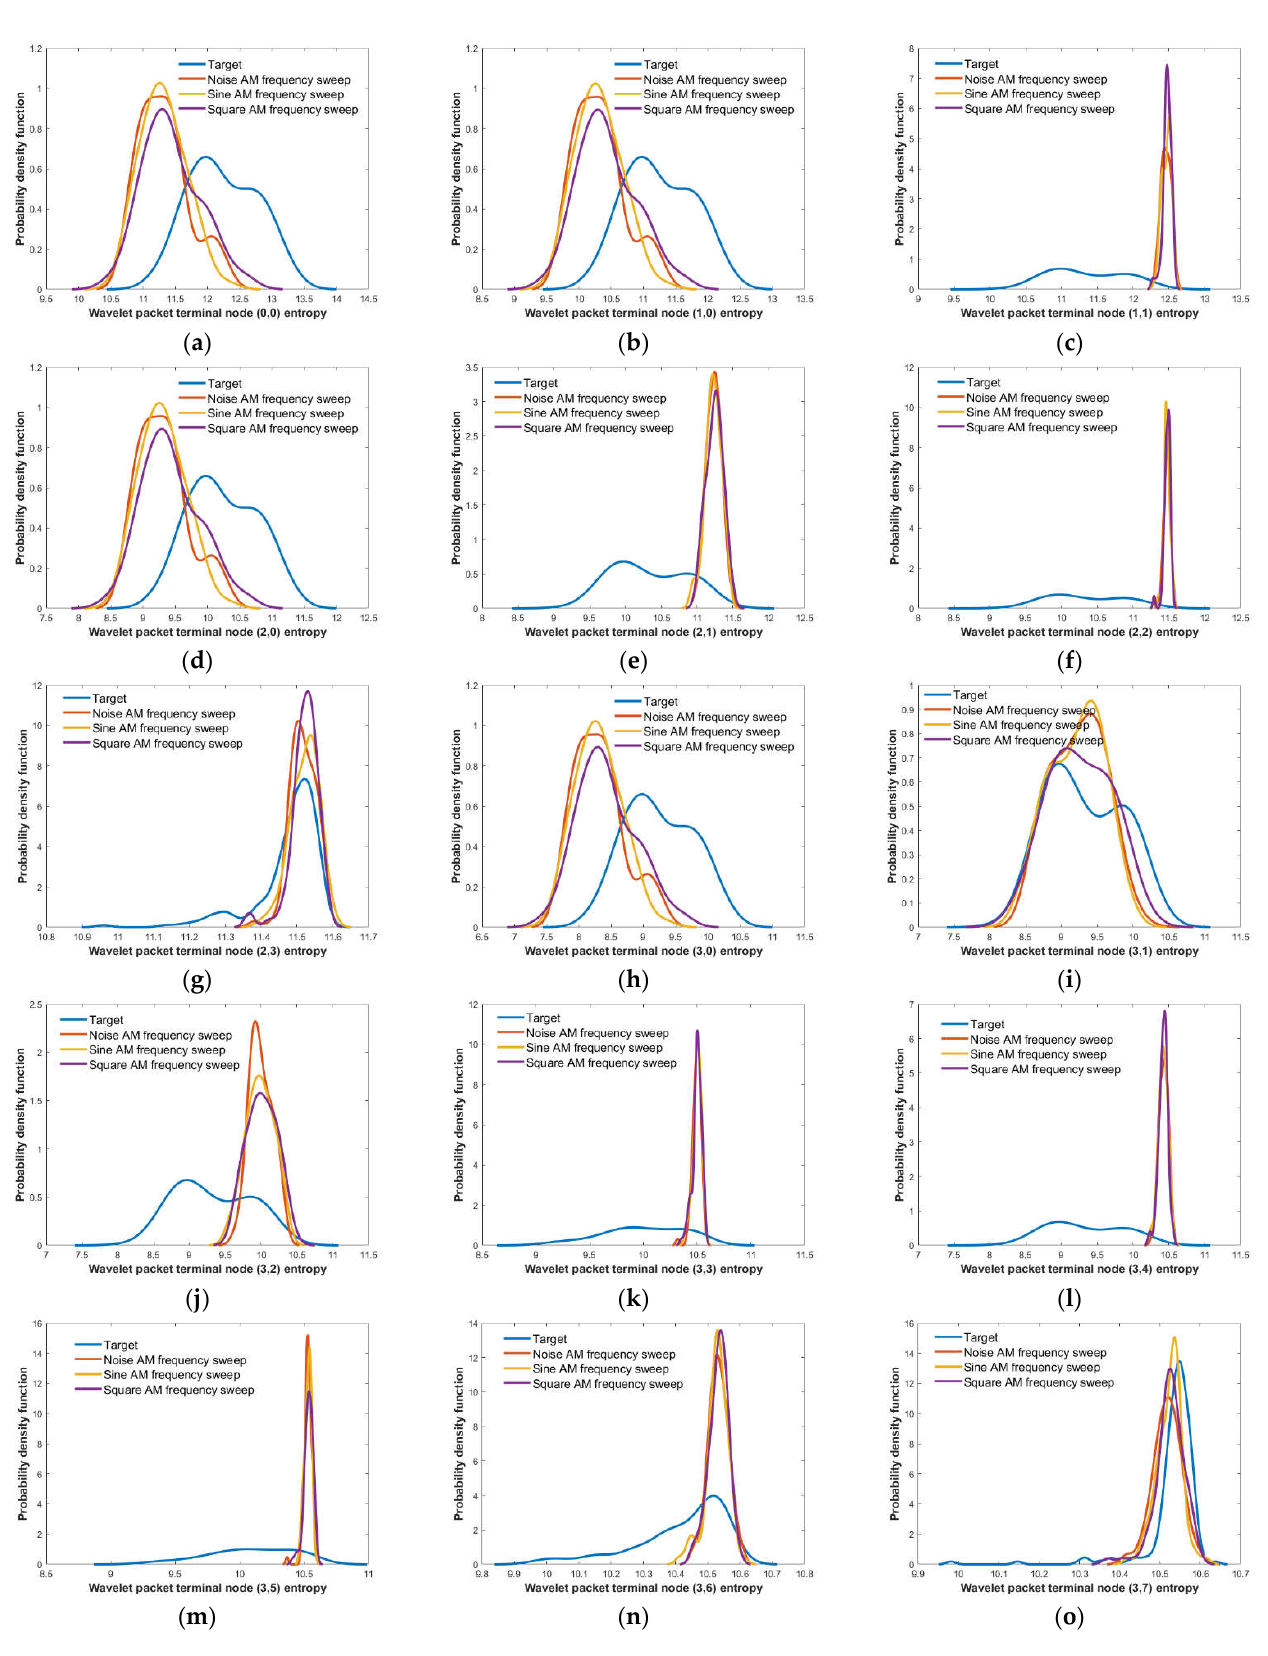
Figure 4. Different signals wavelet packet nodes entropy probability density function. ( a ) Node ( 0,0 ). ( b ) Node ( 1,0 ). ( c ) Node ( 1,1 ). ( d ) Node ( 2,0 ). ( e ) Node ( 2,1 ). ( f ) Node ( 2,2 ). ( g ) Node ( 2,3 ). ( h ) Node ( 3,0 ). ( i ) Node ( 3,1 ). ( j ) Node ( 3,2 ). ( k ) Node ( 3,3 ). ( l ) Node ( 3,4 ). ( m ) Node ( 3,5 ). ( n ) Node ( 3,6 ). ( o ) Node ( 3,7 ).